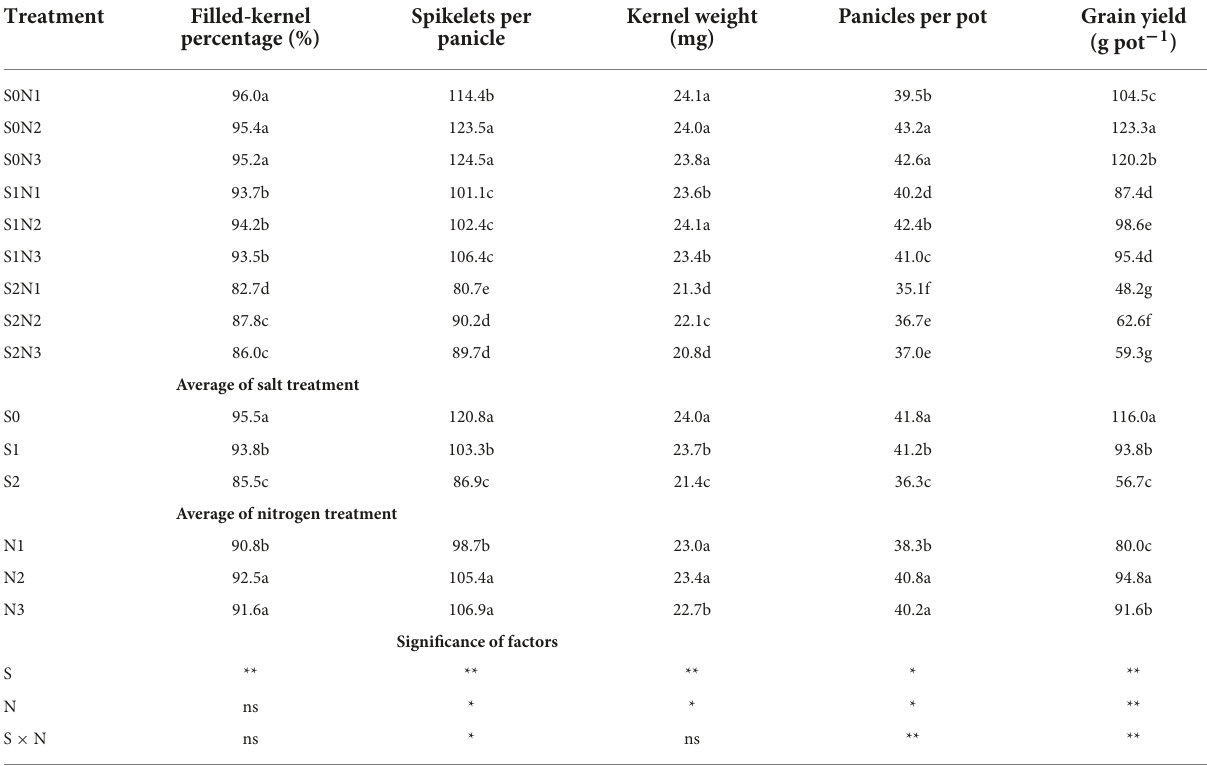
Thevaluesinthesamecolumnfollowedbydifferentlettersindicatestatisticalsignificanceatthe0.05probabilitylevel. TABLE 2 Effects of different salt concentrations and nitrogen rates on rice yield and yield components.